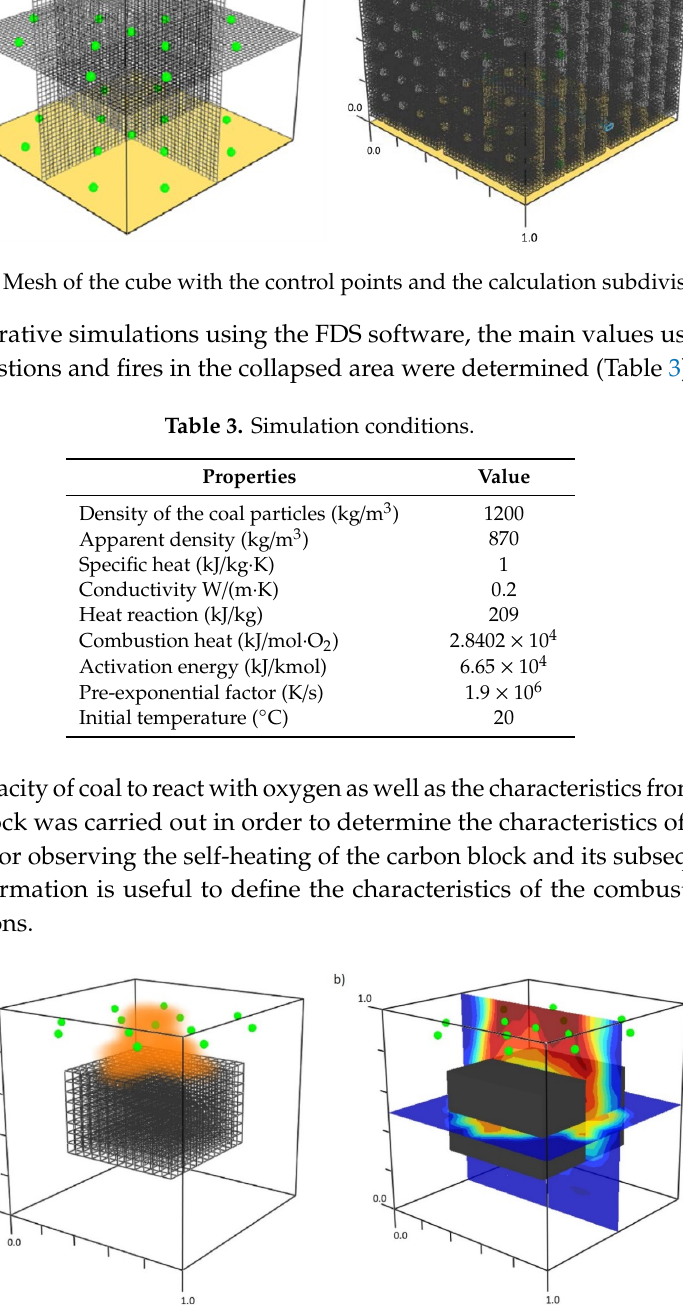
Figure 4. ( a ) Model of the coal combustion at an early stage and ( b ) the combustion